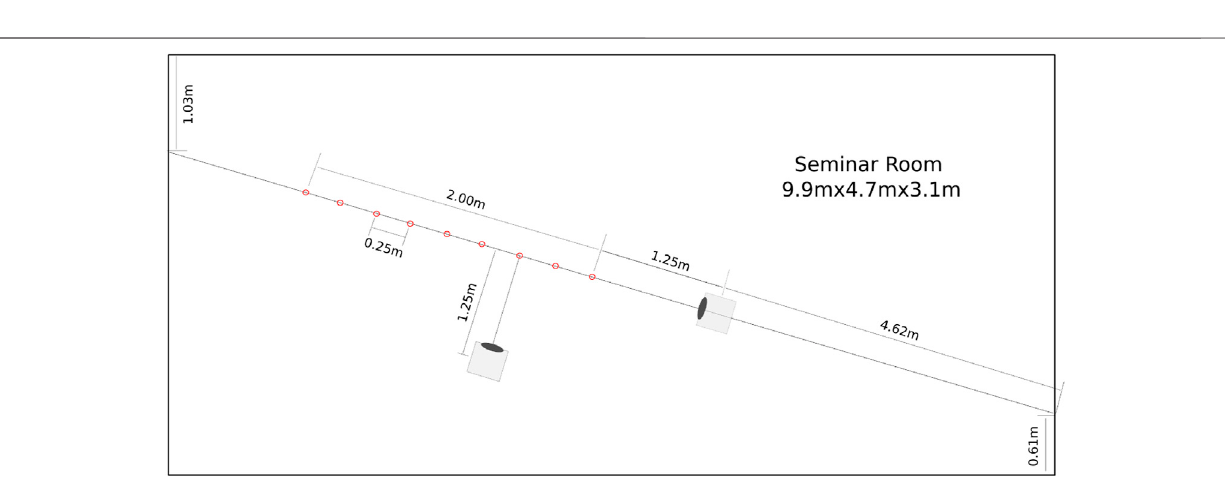
Frontiers in Virtual Reality |